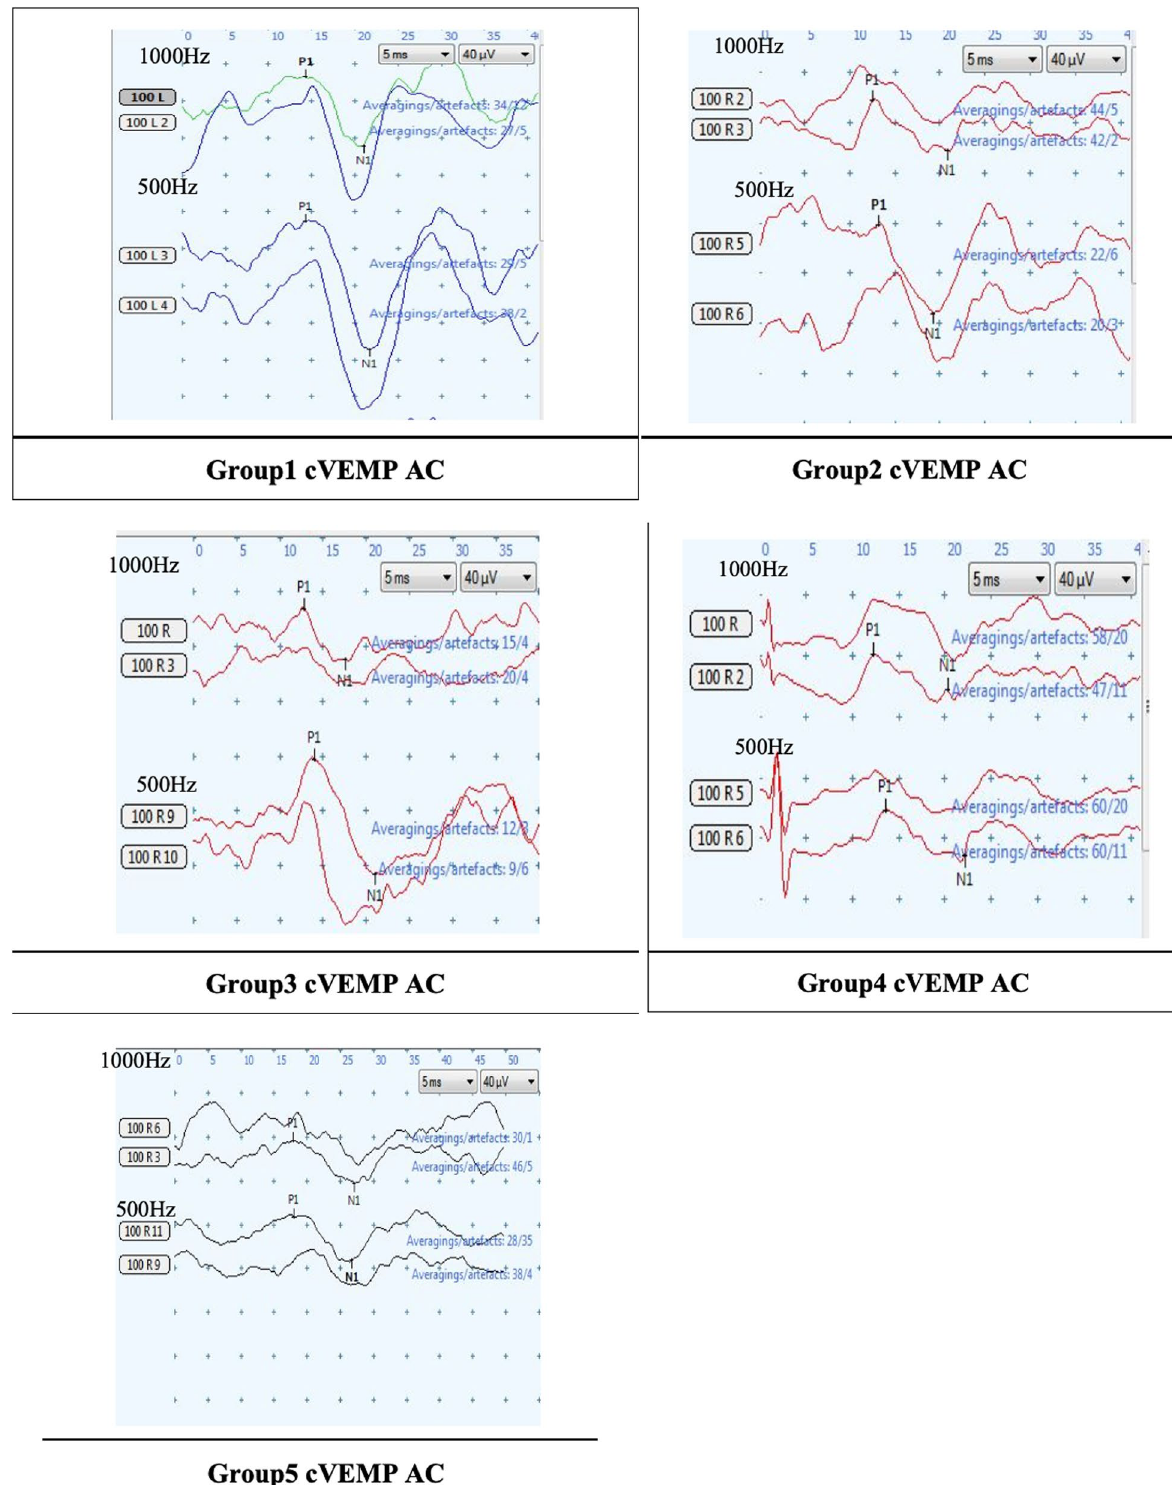
Fig. 1 cVEMP air conduction (AC) traces at 1000 Hz and 500 Hz in the 5 age